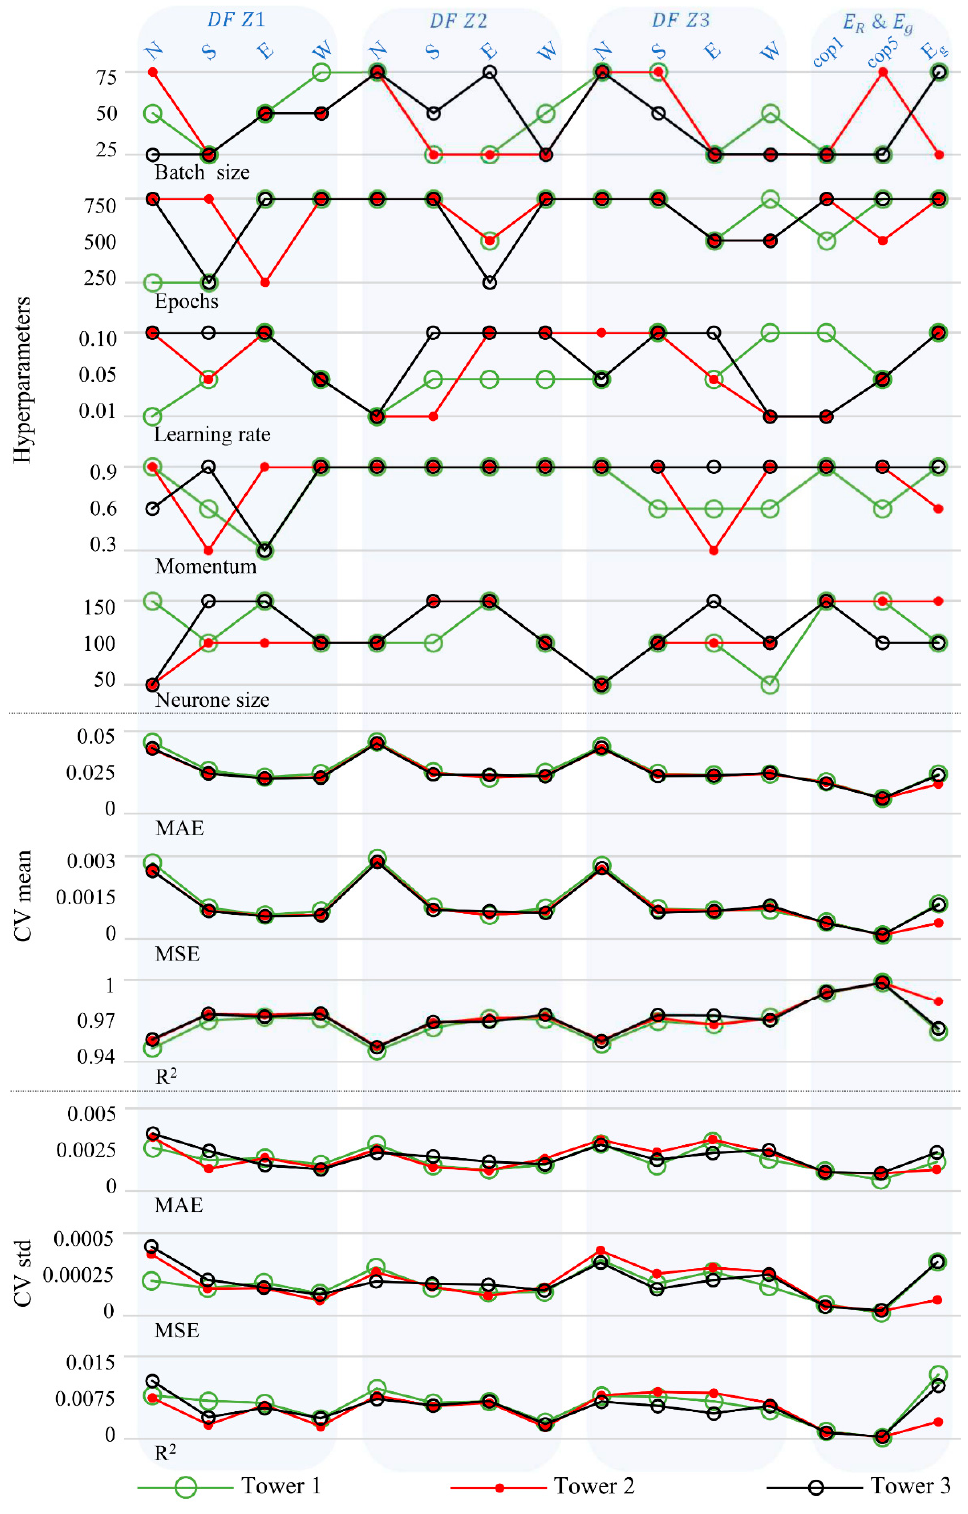
Figure 13. Grid search results of the best ANN models.